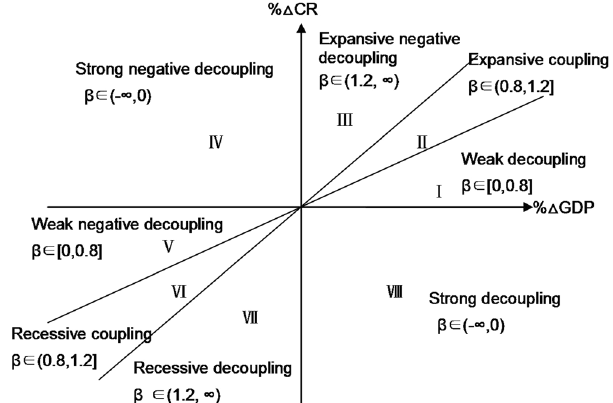
Figure 6. Coordinated figure of decoupling types (modified from Tapio) 39